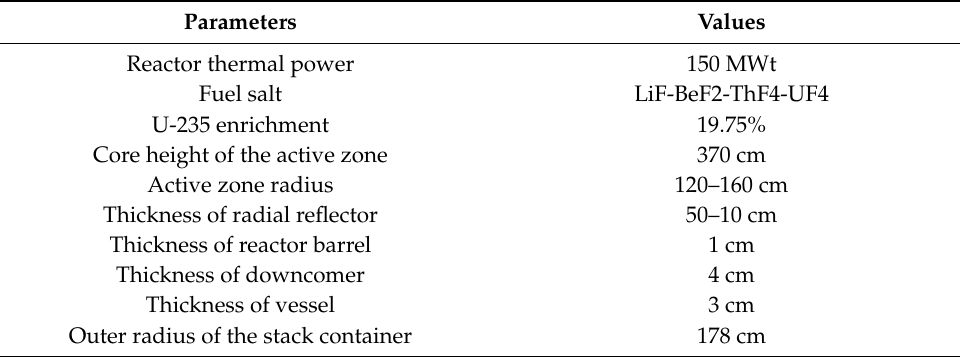
Figure 1. The schematic view of the small modular molten salt reactor: ( a ) top view; ( b ) side view. Table 1. Main design parameters of small modular molten salt reactor.